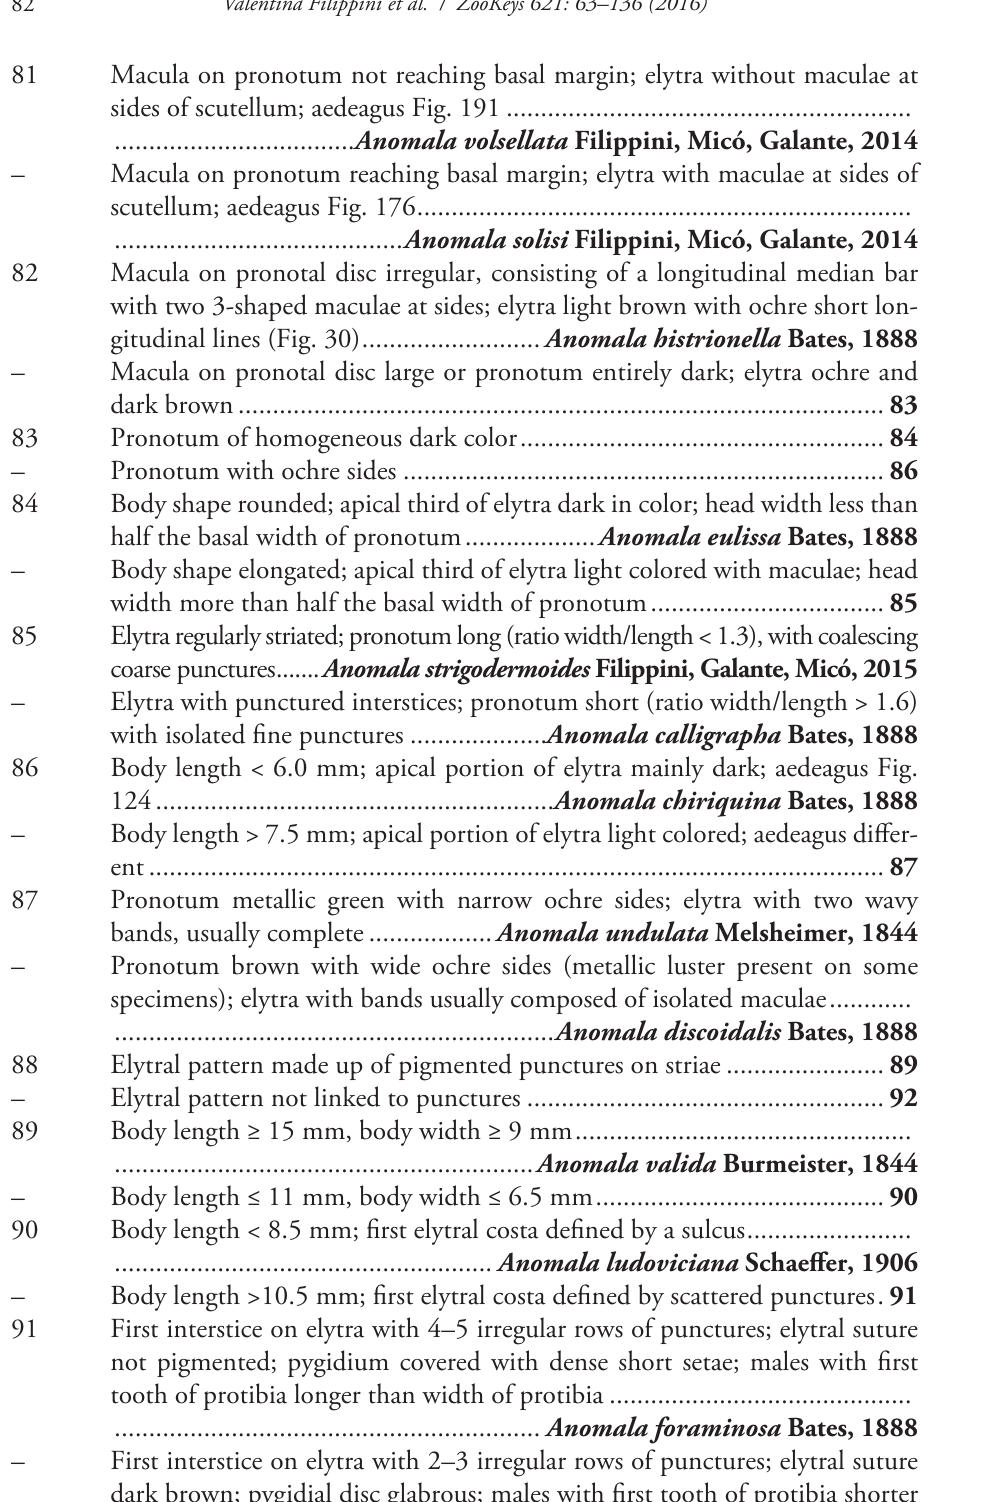
– Macula on pronotum reaching basal margin; elytra with maculae at sides of